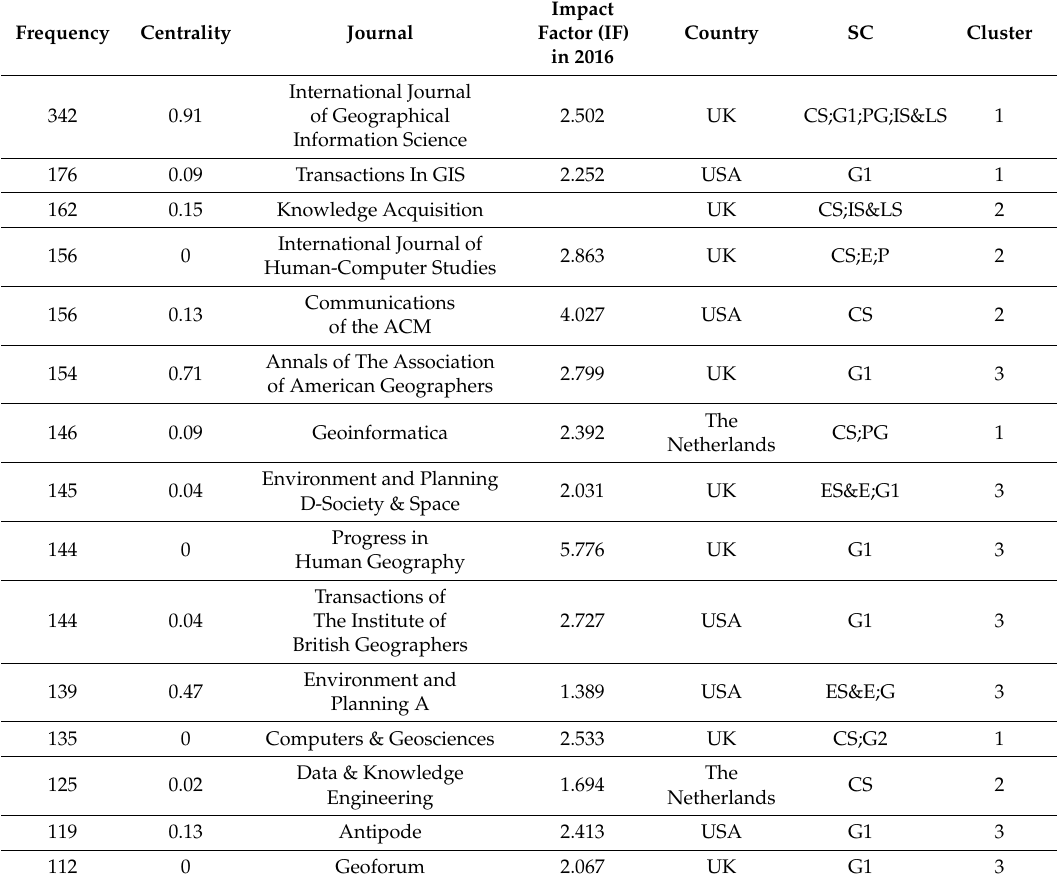
Table 1. Frequency distribution of the top 15 cited journals with their between centrality values.